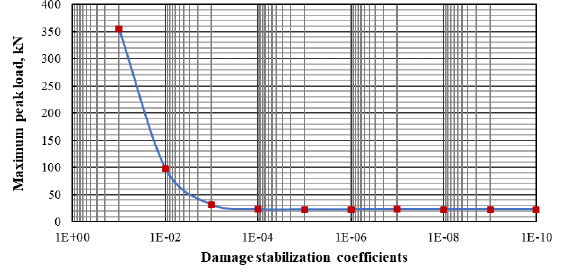
Fig. 11. Findings on meshing study with variables global Fig. 10. Findings on damage stabilization cohesive study sizes assign on a concrete beam using XFEM in FEA modelling.